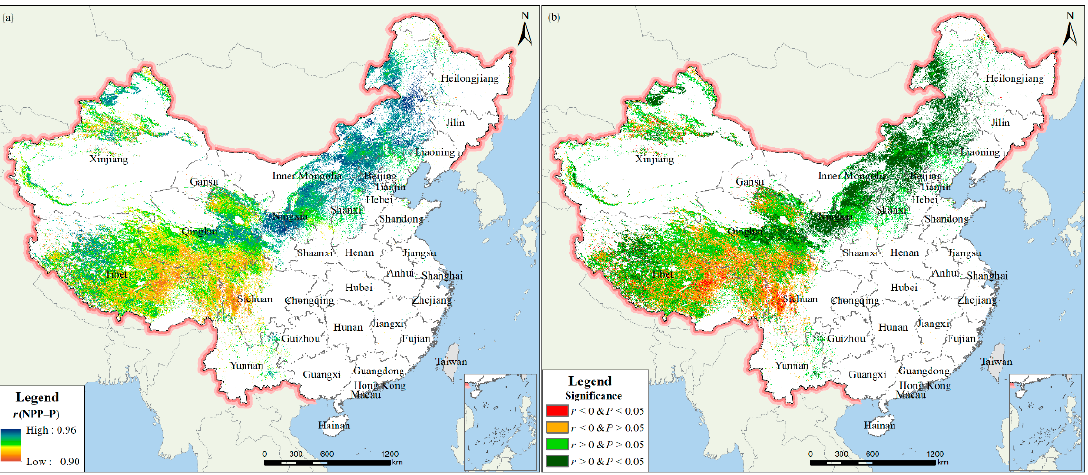
Remote Sens. 2022 , 14 , x FOR PEER REVIEW Figure 13. Spatial patterns of ( a ) partial correlation coefficients between ANPP and annual average total precipitation and ( b ) the corresponding significance levels.